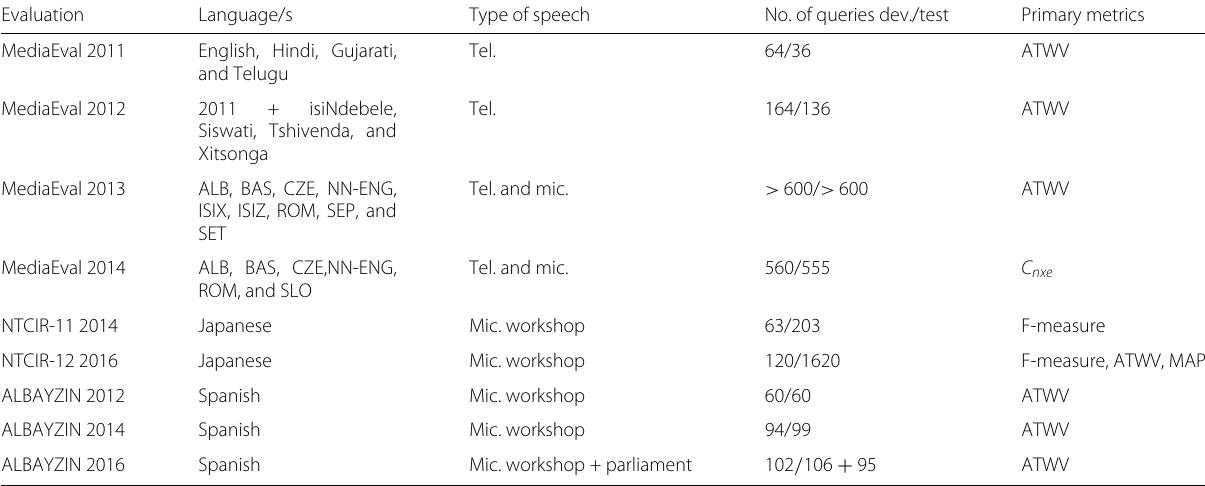
Table 4 Comparison of the different QbE STD evaluations: Albanian (ALB), Basque (BAS), Czech (CZE), non-native English (NN-ENG), Isixhosa (ISIX), Isizulu (ISIZ), Romanian (ROM), Sepedi (SEP), Setswana (SET), and Slovak (SLO) Evaluation Language/s Type of speech No. of queries